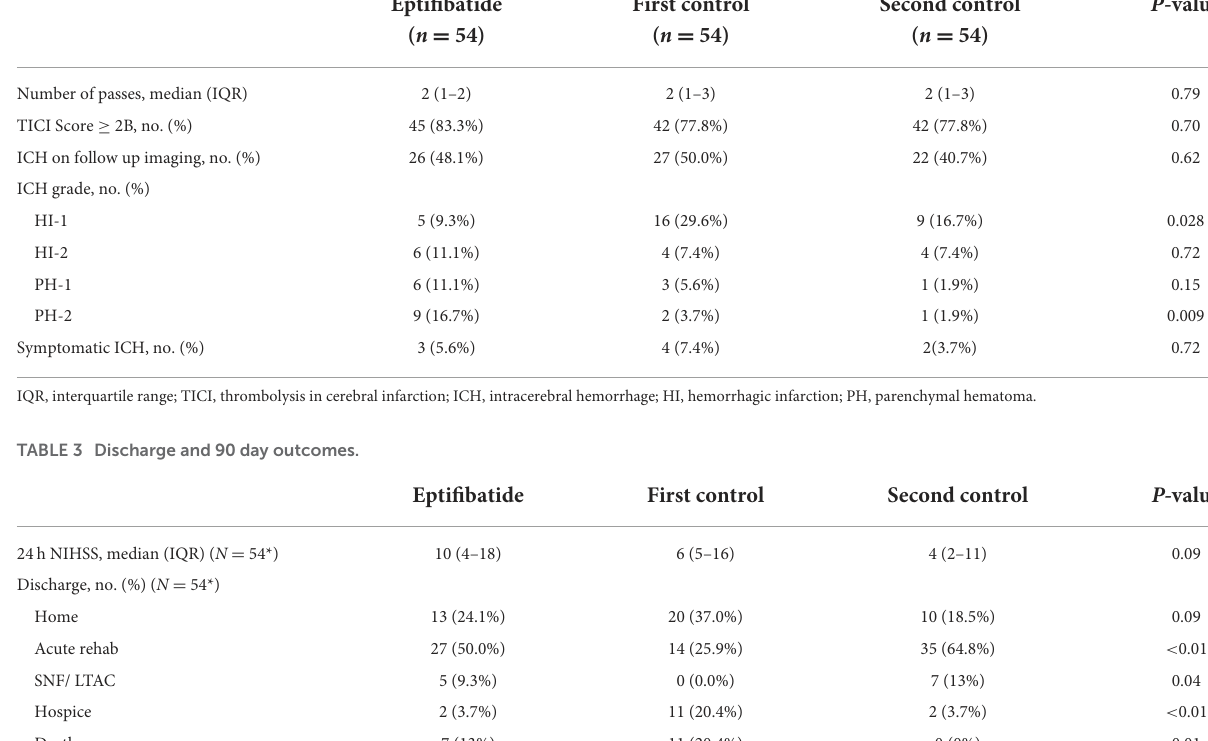
TABLE 2 Endovascular treatment outcomes and grades of hemorrhagic transformation on subsequent imaging. Eptifibatide